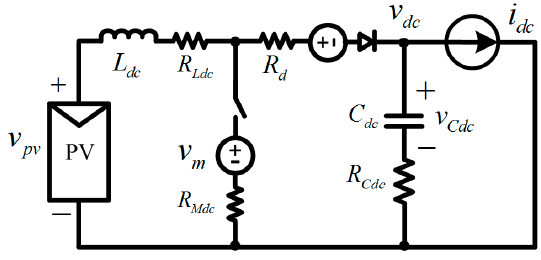
Figure 6. Circuit model for the dc-dc converter.